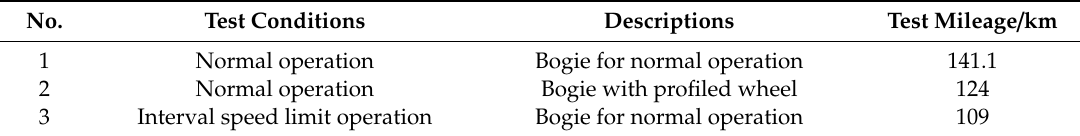
Table 1. Testing conditions for dynamic stress and vibration acceleration.